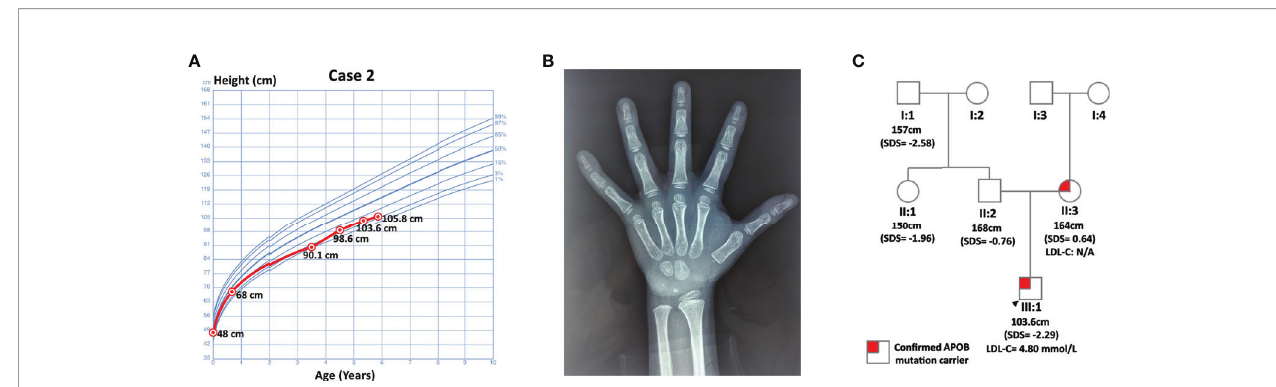
FIGURE 1 | Information on case 1. (A) Growth curve. (B) Plain X-ray of left hand and wrist. (C)